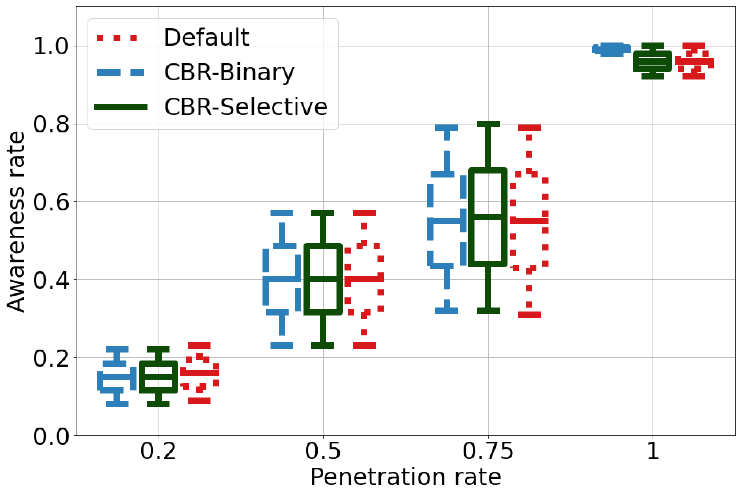
Figure 5. Awareness rate function of penetration rate for CBR-Selective, CBR-Binary and Default algorithms.